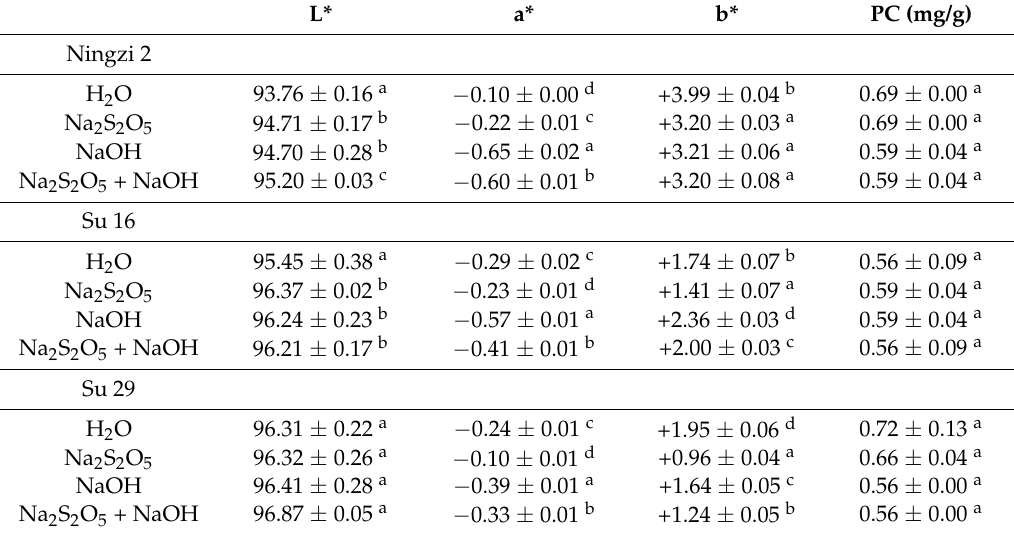
Table 1. Color parameters and protein content (PC) of